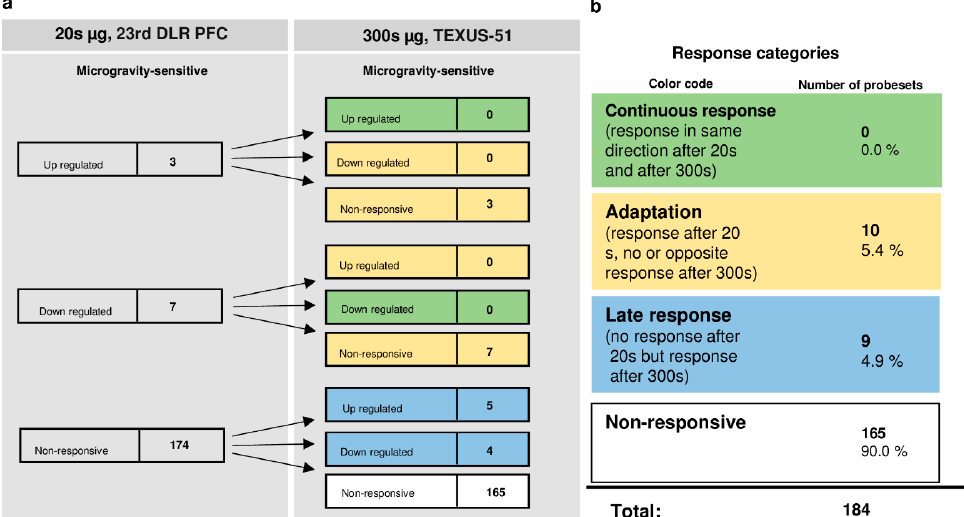
Figure 8. Time course of differential expression of 184 probe sets in human Jurkat T cells after microgravity exposure (list of probe sets in Supplementary Table S1). Human Jurkat T cells were exposed to 20 s and 300 s of microgravity. The probe sets are grouped according to their regulation after the two exposure times. Continuous response means that probe sets are either up-regulated or down-regulated at both time points. Adaptation is either the disappearance of the microgravity-induced effect or regulation in the opposite direction after 300 s. A late response is a regulation that only appears after 300 s. Most of the probe sets did not respond to microgravity at either time point. For the abbreviations of the experiment group names see Table 1.